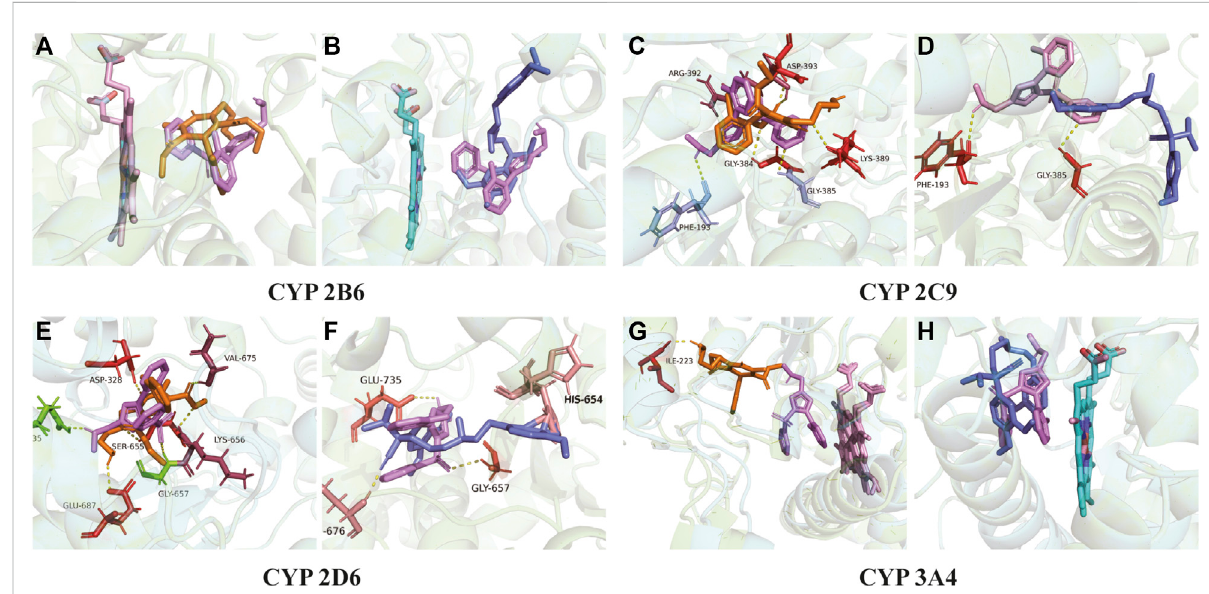
FIGURE 8 Molecular docking. (A) Action position of amlodipine and vonoprazan in CYP 2B6 enzyme. (B) Action position of verapamil and vonoprazan in CYP 2B6 enzyme. (C) Action position of amlodipine and vonoprazan in CYP 2C9 enzyme. (D) Action position of verapamil and vonoprazan in CYP 2C9 enzyme. (E) Action position of amlodipine and vonoprazan in CYP 2D6 enzyme. (F) Action position of verapamil and vonoprazan in CYP 2D6 enzyme. (G) Action position of amlodipine and vonoprazan in CYP 3A4 enzyme. (H) Action position of verapamil and vonoprazan in CYP 3A4 enzyme. The yellow dotted lines connect the acting sites between drugs and enzymes via hydrogen